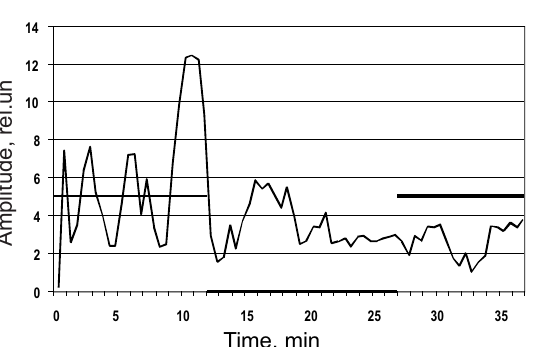
Fig. 6. The dependence of amplitude of the interferometer signal on the schedule of SURA during reception of the signal from the satellite NSS GPS ‘26605’; 2012-03-23; the interferometer